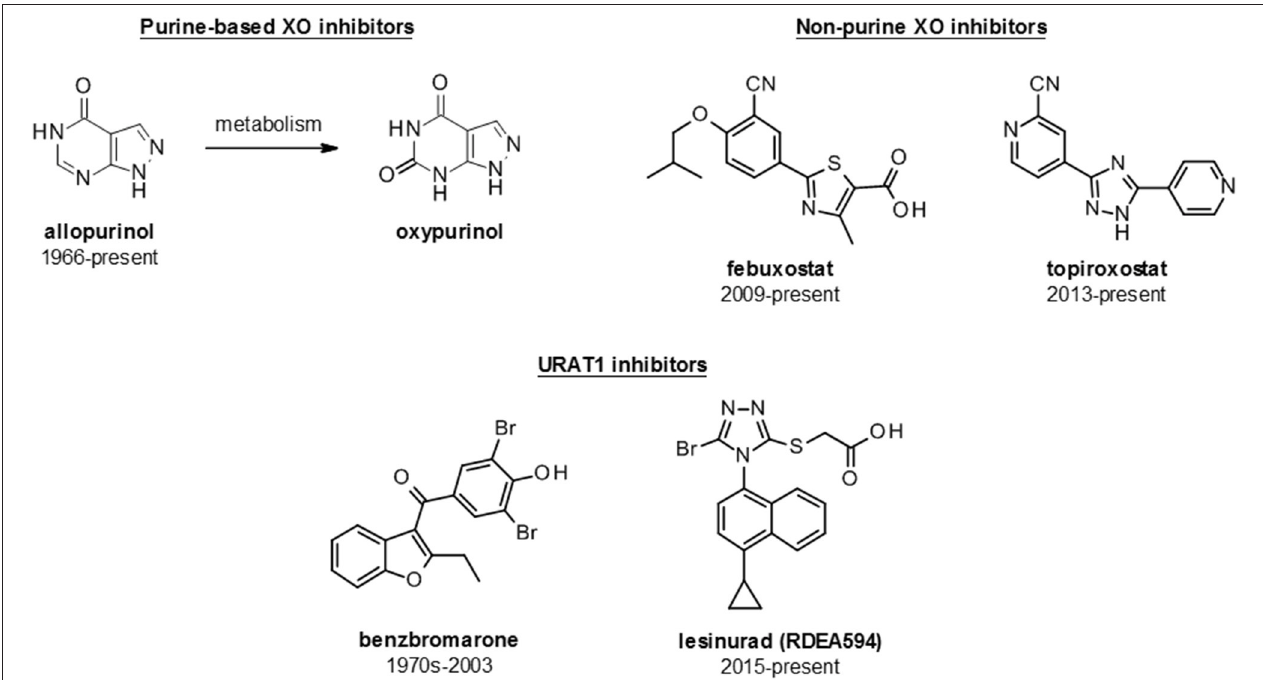
FIGURE 5 | Structures of launched (marketed and withdrawn) drugs for the management of hyperuricemia. Purine-based (allopurinol and oxypurinol) and non-purine based (febuxostat and topiroxostat) XO inhibitors are shown with dates of approval for clinical use. URAT1 inhibitors are represented by benzbromarone (withdrawn in 2003) and lesinurad (RDEA594).